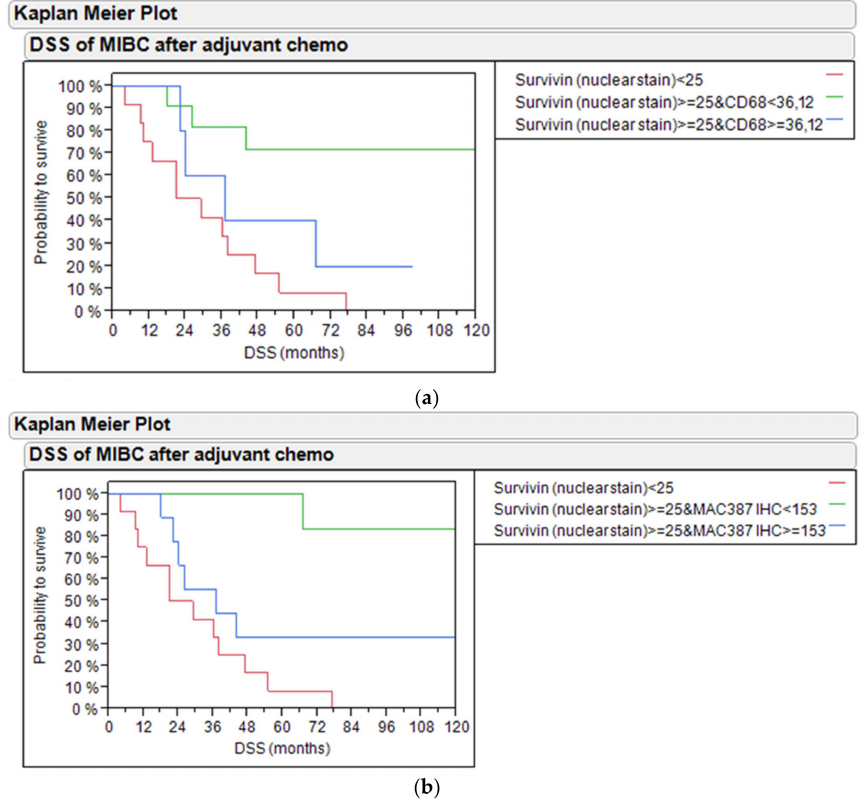
Figure 7. ( a ) DSS of bladder cancer patients treated with adjuvant chemotherapy based on survivin nuclear protein staining and CD68 mRNA in the PCR and IHC cohort. ( b ) DSS of bladder cancer patients treated with adjuvant chemotherapy based on survivin nuclear protein staining and MAC387 protein in the PCR and IHC cohort.